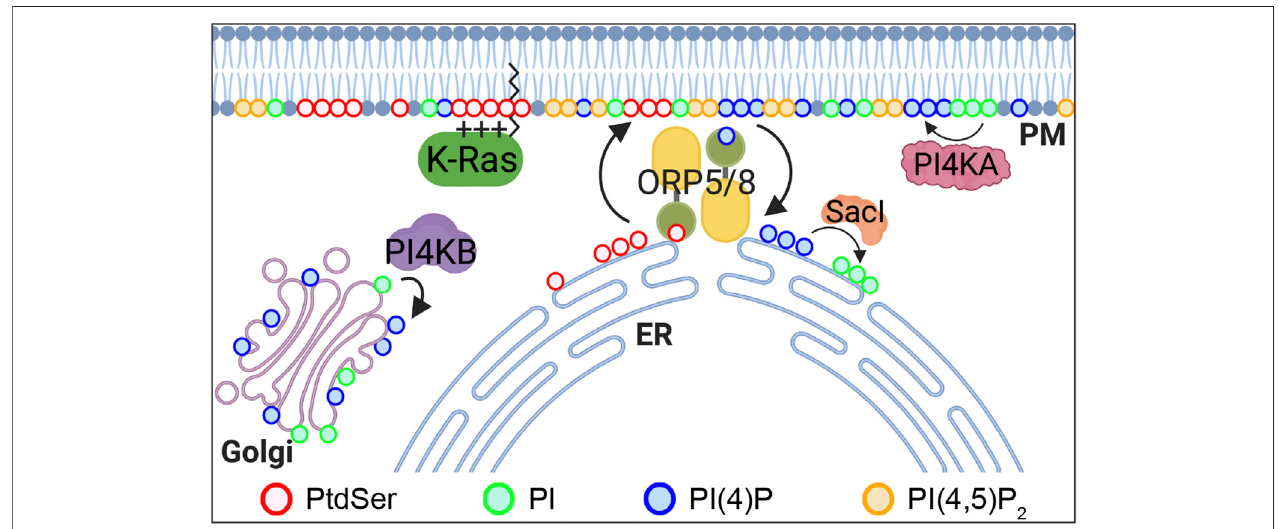
FIGURE2| PtdSerPMenrichmentisregulatedbyORP5and8.ORP5and8arelipidtransportersthatexchangeERPtdSerwithPMPI4P.Thedrivingforce ofthis process isaPI4P concentration gradient, whereby PI4P levels are high in thePM byPI4KA and are kept low at theER bySac1 phosphatase, which converts PI4P toPI. PI4P is also generated at the Golgi complex by PI4KB. ORP, oxysterol-binding protein – related protein; PtdSer, phosphatidylserine; PI, phosphatidylinositol; PI4P, PI 4- phosphate; PI(4,5)P2, PI(4,5)-bisphosphate; PI4KA, PI 4-kinase III α ; PI4KB, PI 4-kinase III β .